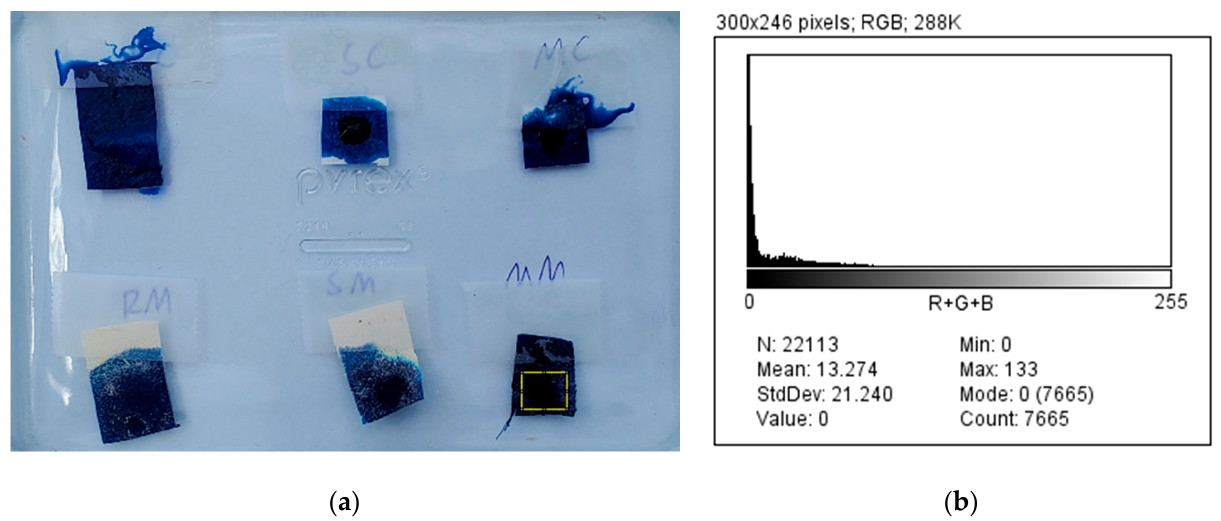
Figure 2. ( a ) Filters soaked in methylene blue; ( b ) Color histogram using ImageJ.